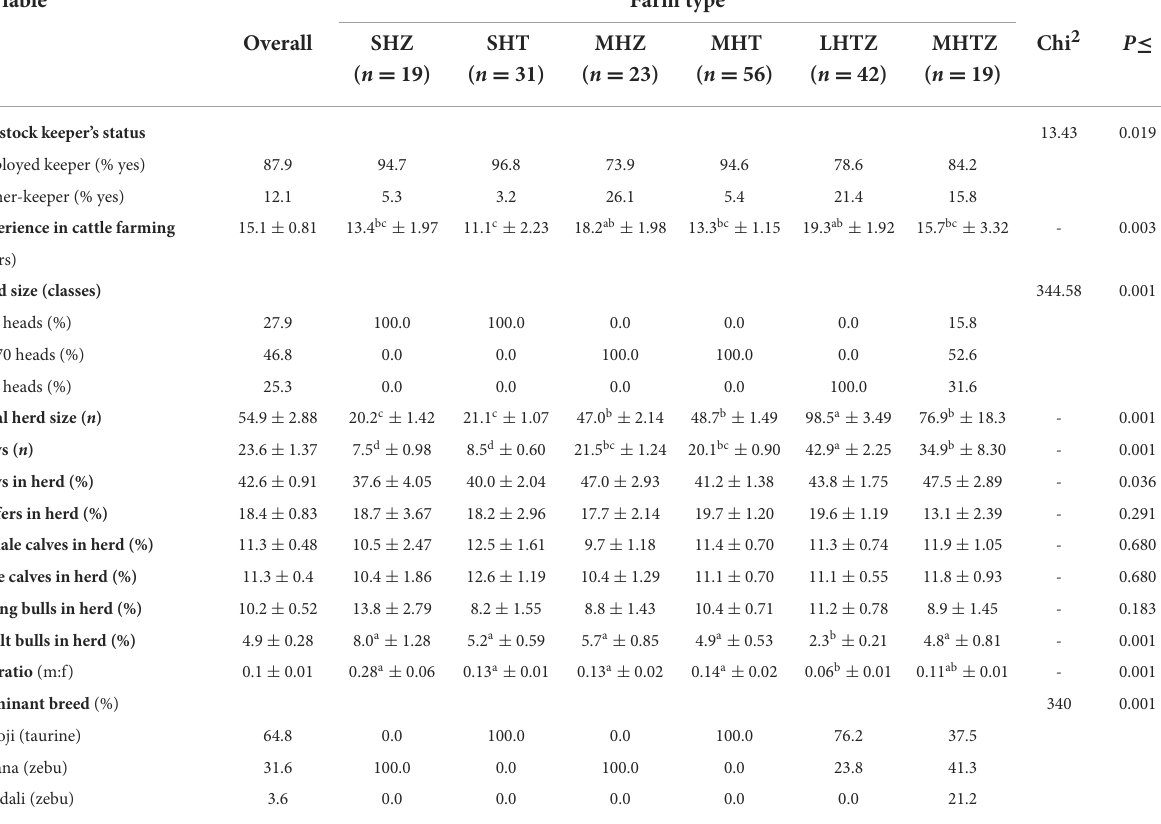
TABLE 5 Main characteristics of the six different dairy farm types in the peri-urban area of southern Benin; data depict either frequencies (%) or means ± standard error. Variable